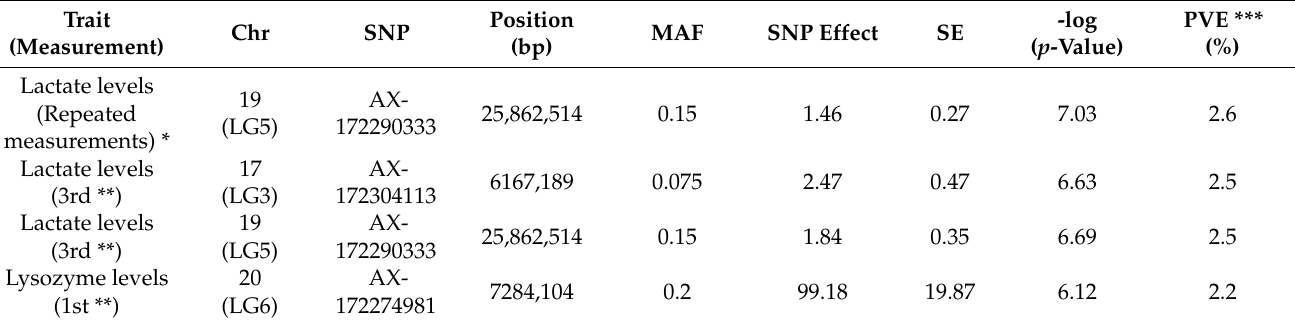
Analyzing batch 10, the QTL affecting lactate levels at the 3rd measurement located in chromosome 19 (LG5) was also detected to be significant in the present subgroup, with an approximately similar effect (PVE, 2.3%, Table